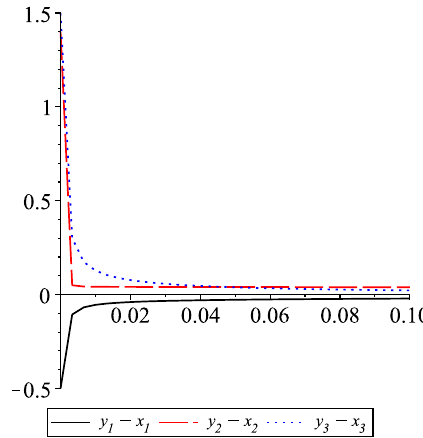
Figure 4: Graphs of the di ff erences between the solutions of the master system ( 20 ) and the slave system ( 21 )